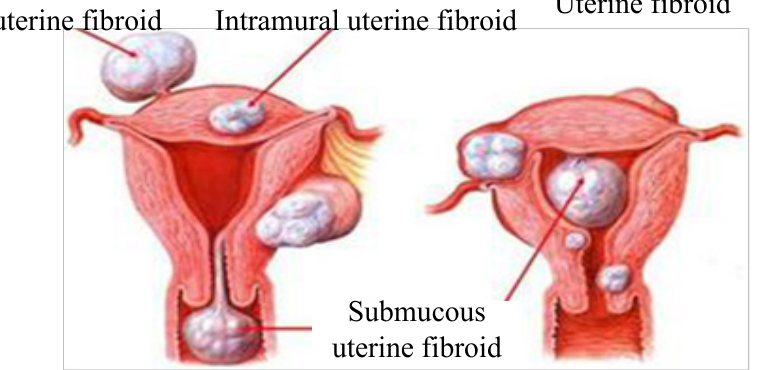
Figure 3. Types of the patients’ uterine fibroids Table 1. General data of selected patients Number of